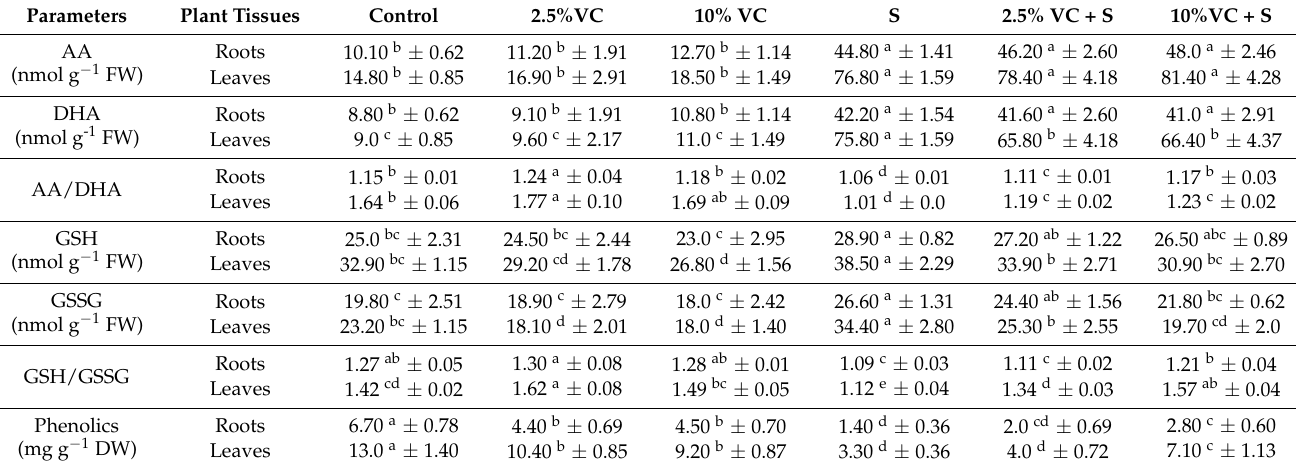
Table 5. Effect of 0, 2.5 and 10% vermicompost, 200 mM NaCl (S) and their interactions on the contents of ascorbate (AA), dehydroascorbate (DHA), AA/DHA, reduced glutathione (GSH), oxidized glutathione (GSSG), GSH/GSSG, and phenolics in the roots and shoots of broad bean plants after 30 days of cultivation. Values are means ± SD based on triplicate independent determinations, and different letters means significant difference as evaluated by Duncan’s multiple comparison test ( p <